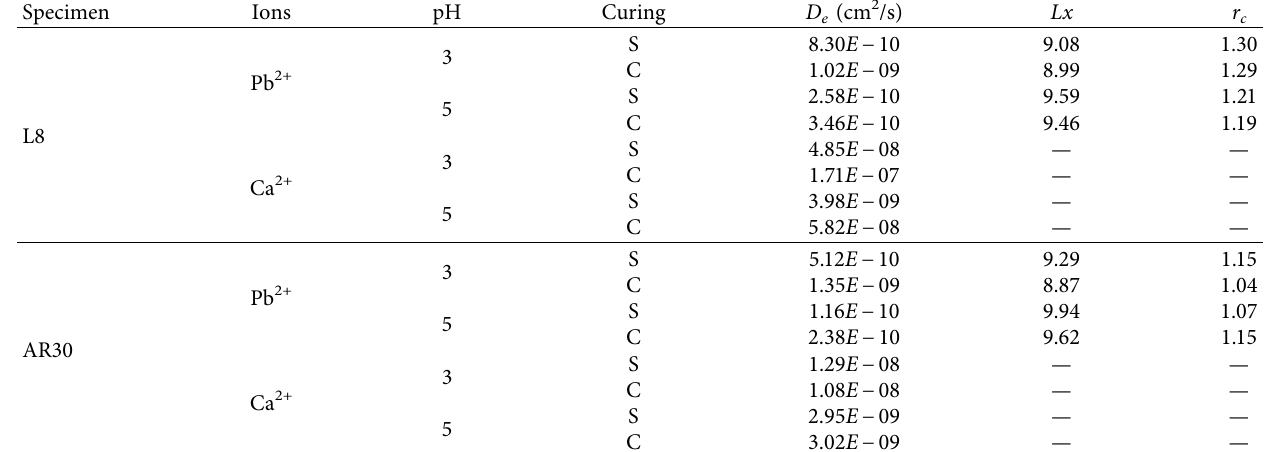
Table 3: Computed values of each index related under different conditions. Specimen